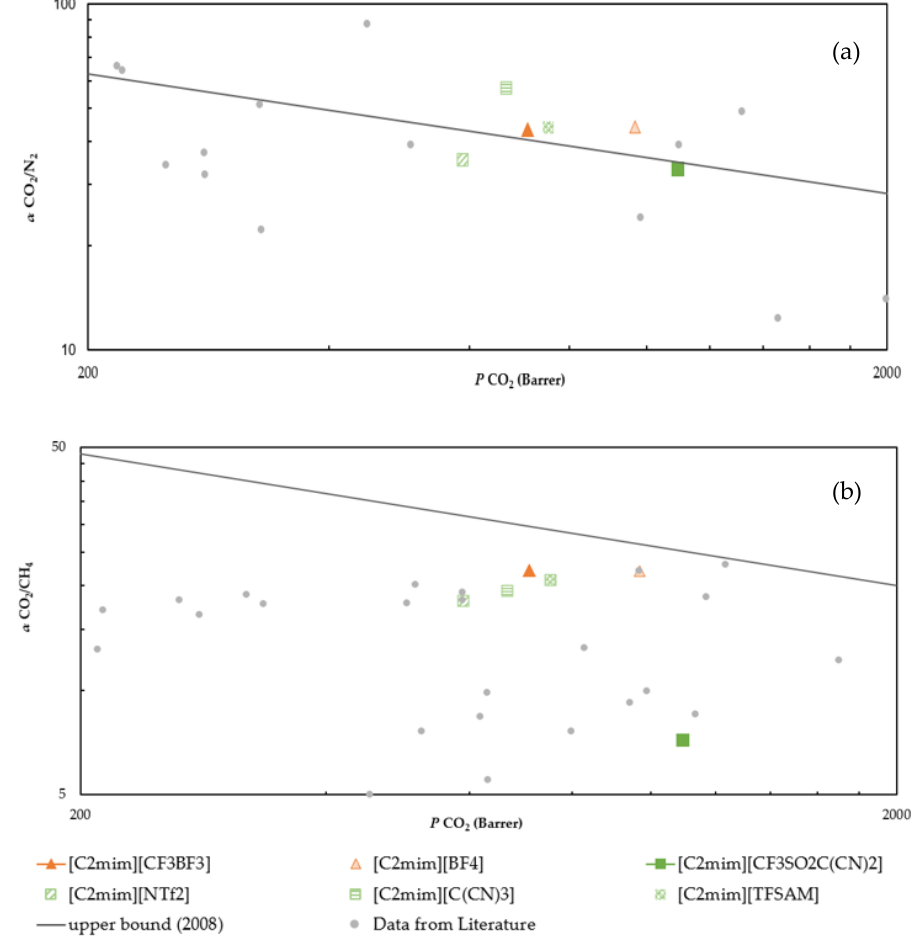
Figure 6. CO 2 /N 2 ( a ) and CO 2 /CH 4 ( b ) separation performance of [C 2 mim][CF 3 BF 3 ] and [C 2 mim][CF 3 SO 2 C(CN) 2 ] SILMs Robeson plots [45]. Literature data for other SILMs was used for comparison [28,29,57,64,66-73].